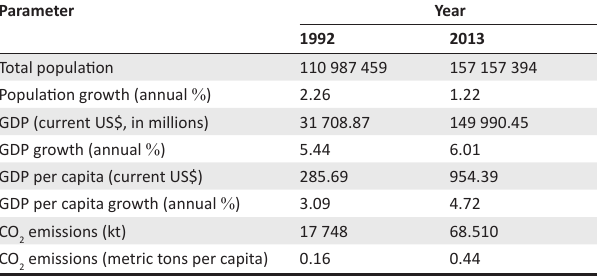
TABLE 1: Growth of population, gross domestic product and carbon dioxide in